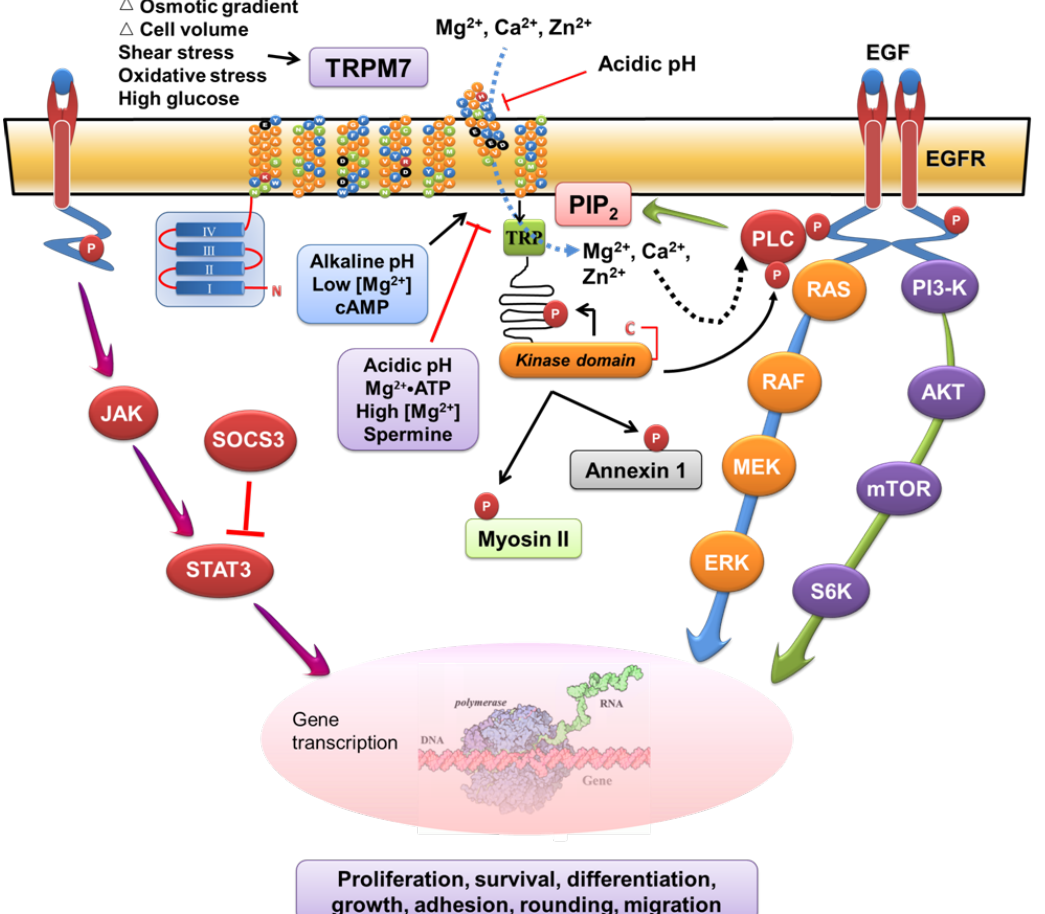
Figure 2. A working model of the signaling mechanisms that mediate the functional roles of